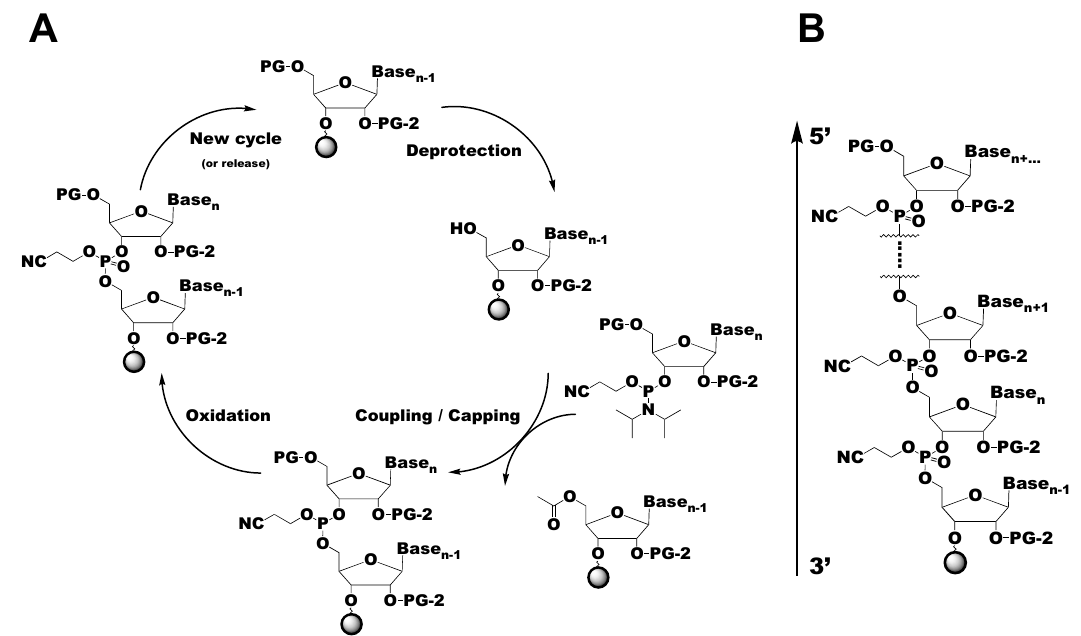
Figure 2. Overview of the solid-phase chemical RNA synthesis cycle. ( A ) Schematic of the solid-phase synthesis cycle of RNA, with the coupling of residue n-1 and n shown. PG refers to the 5 ′ -OH protecting group, which is generally DMTr. PG-2 refers to the 2 ′ -OH protecting group, which comes in many varieties, as discussed in this review. Additional cycles can be added to the synthetic cycle to grow the RNA polymer from 3 ′ –5 ′ ( B ).